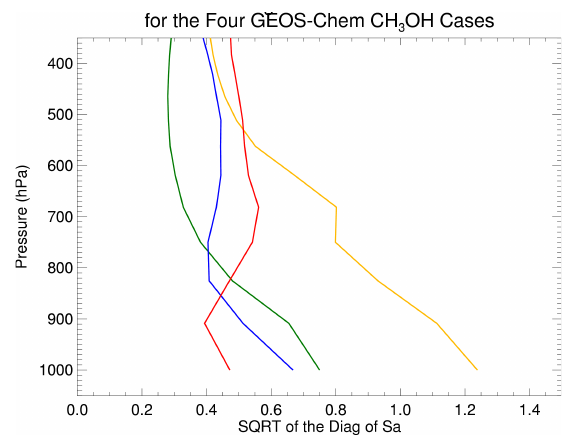
Fig. 4. Square root of the diagonal of the covariance matrices for each of the profile types shown in Fig. 3 (green: clean marine, blue: enhanced marine, yellow: clean continental, red: enhanced conti- nental). Note that the covariance matrix is calculated in log